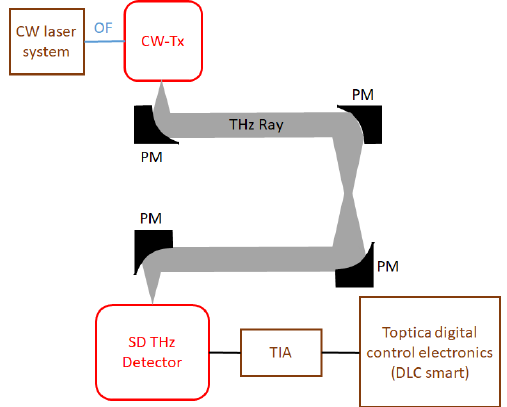
Figure 2. The experimental setup used to characterize the detectors with the table-top CW transmitter from Toptica/HHI. In the setup, OF: Optical fiber, CW-Tx: Continuous wave transmitter, PM: Parabolic mirror, SD: Schottky Diode THz detector and TIA: Trans-impedance